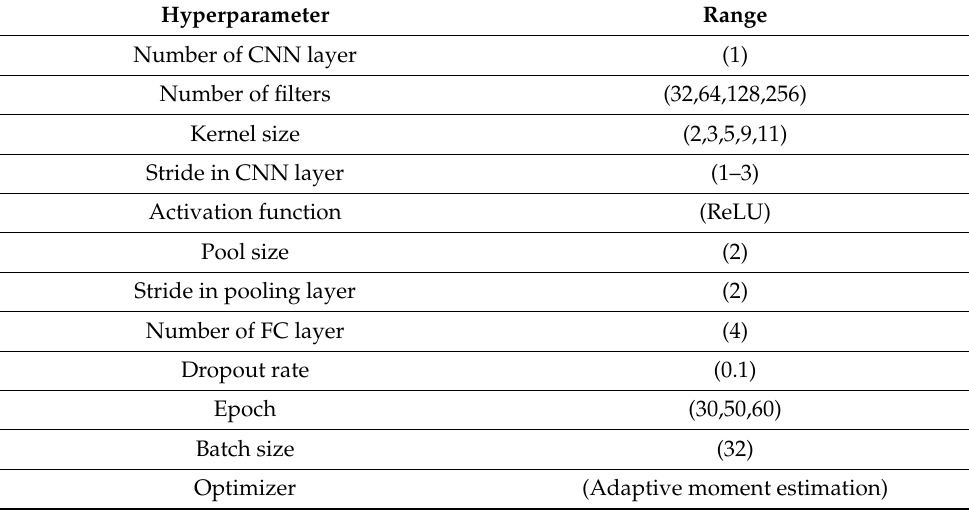
Table 3. Hyperparameter ranges of 1D-CNN models.